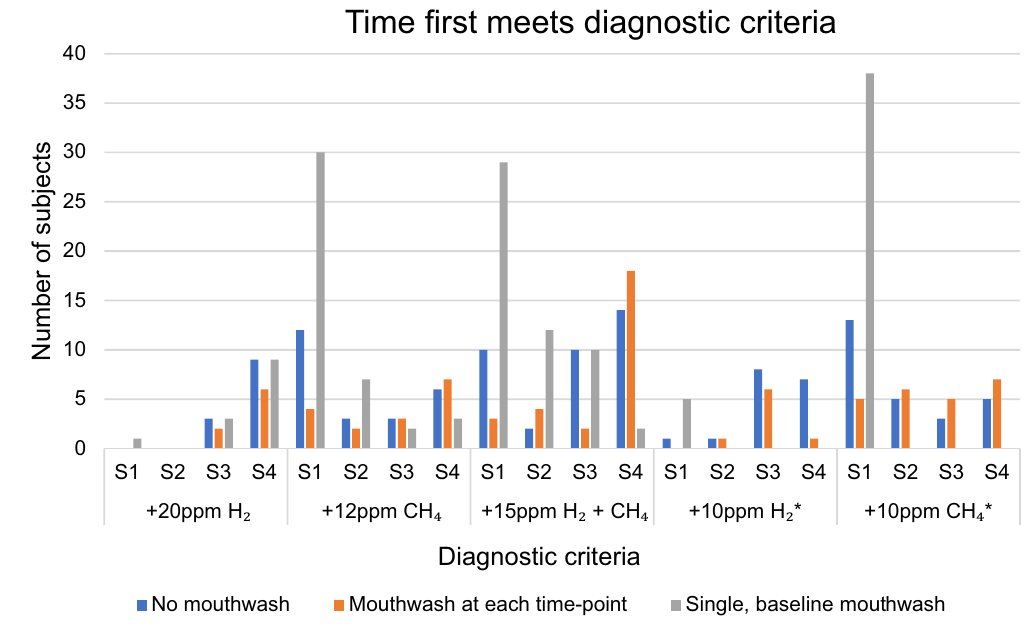
Figure 4. How a chlorhexidine mouthwash influences the time a subject meets various diagnostic criteria for small intestinal bacterial overgrowth during Hydrogen–methane breath testing. S, sample number post-baseline; H 2 , hydrogen; CH 4 , methane; *, between 2 sequential